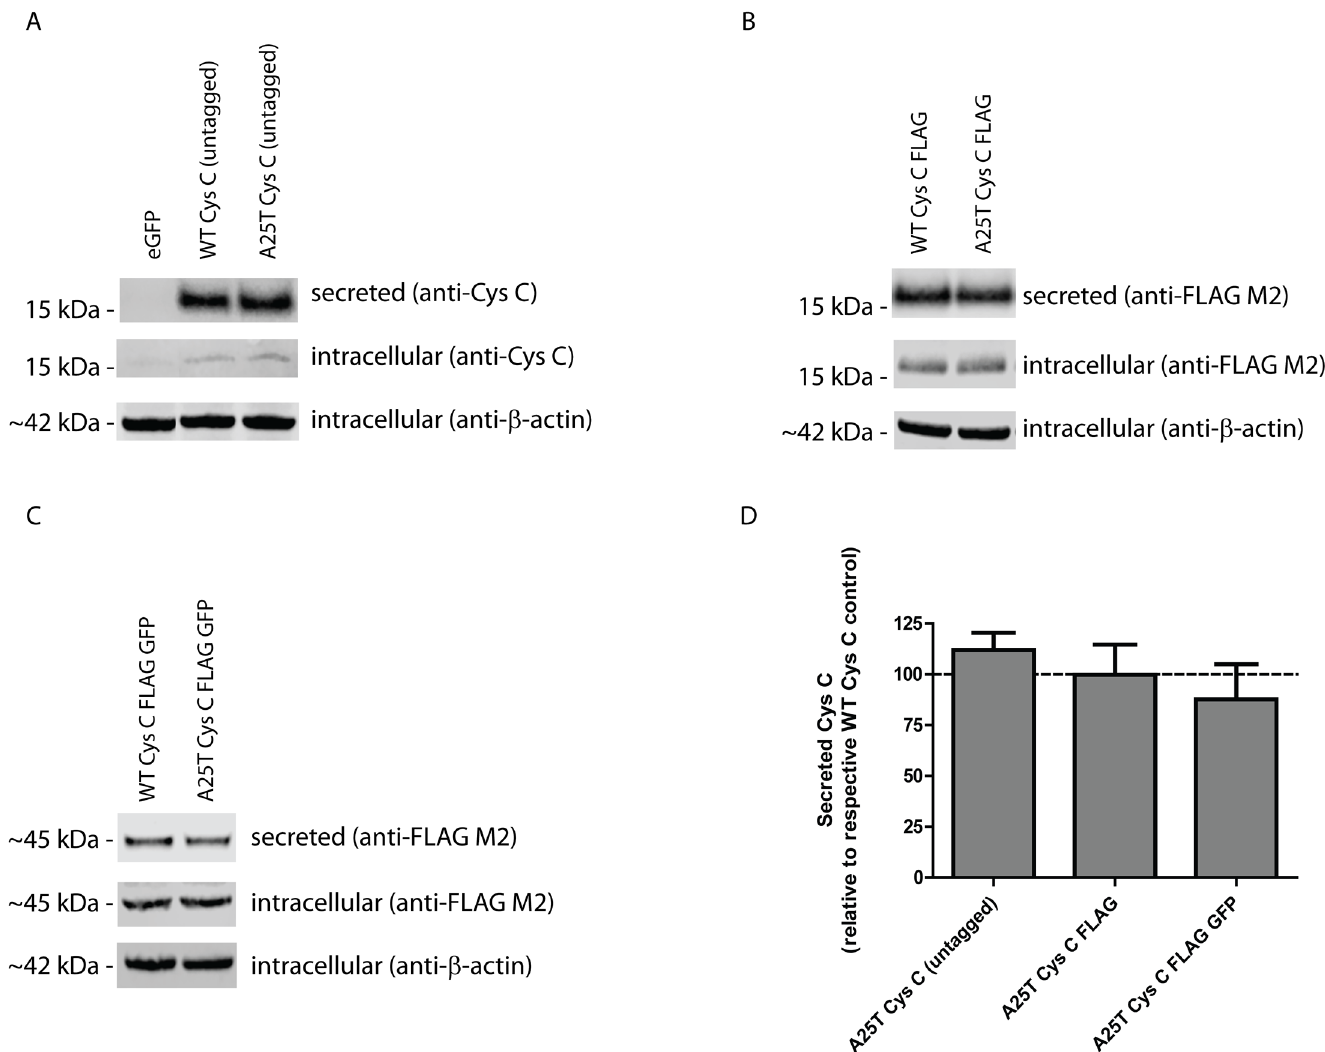
Fig 1. A25T Cys C is secreted as efficiently as WT Cys C from HEK-293T cells. (A-C) HEK-293T cells were transfected with (A) untagged WT or A25T Cys C constructs, (B) WT or A25T Cys C FLAG constructs, or (C) WT or A25T Cys C FLAG GFP constructs. Forty-eight hours post transfection, conditioned media (40 μ L) or cell lysates (40 μ g) were run under denaturing, reducing conditions (with lithium dodecyl sulfate and DTT) on a 4 – 12% BOLT gel. Proteins were transferred to nitrocellulose membranes, probed with an anti-Cys C (1:500, Pierce), anti-FLAG M2 (1:2000, Sigma) or anti- β -actin (1:10,000, Sigma, or 1:2,000, LI-COR) antibody followed by an infrared-conjugated secondary antibody (1:10,000, LI-COR), representative data of at least 3 independent experiments. (D) Secreted protein bands were quantified using LI-COR software and data was presented as A25T Cys C secretion levels as percent of each respective WT Cys C control. n (cid:1) 7, mean ±